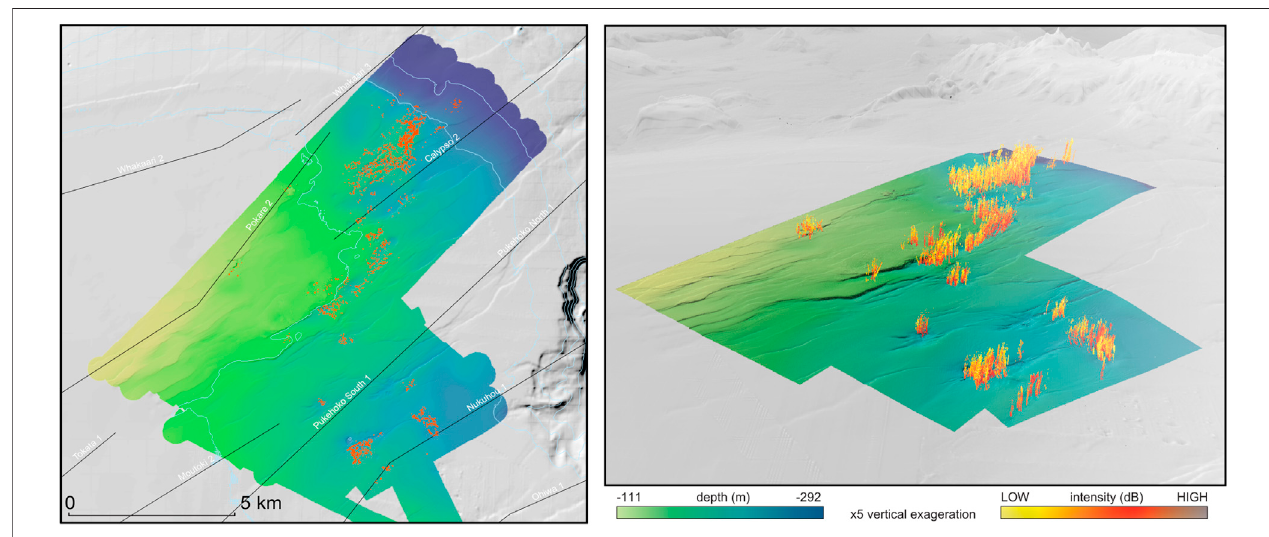
FIGURE 2 | Plan and 3D view of water-column acoustic fl ares collected on the TAN1806 survey overlain Calypso HVF bathymetry (colored) and regional Bay of Plenty bathymetry (greyscale). Plan view show seep base locations (orange points) and fault lines (black lines) from Litch fi eld et al. (2013).